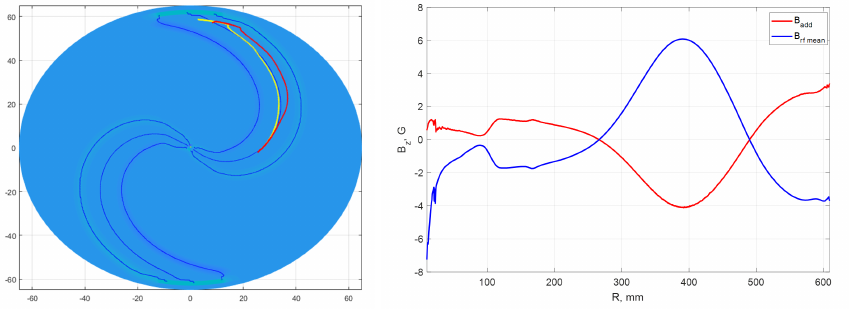
Figure 4. Left: Beam phase delay, red line shows the influence of the RF system, yellow - phase without influence. Right: Mean value of B rf field (blue line) and additional field versus radius.